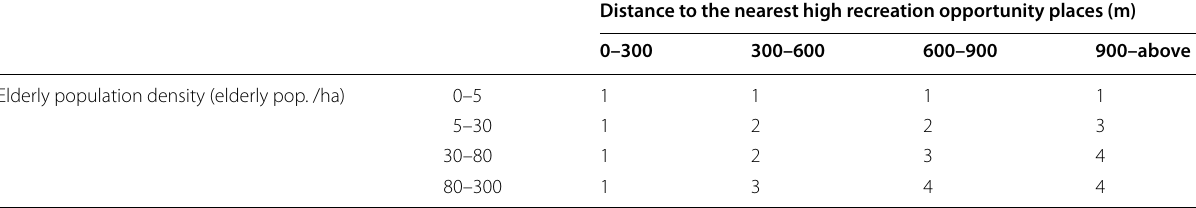
The demand level of each analytical unit is determined by the cross-tabulation of (1) the elderly people density and (2) the distance to the nearest high recreation opportunity places The approach was derived from Baró et al. (2016) and Paracchini et al. (2014)